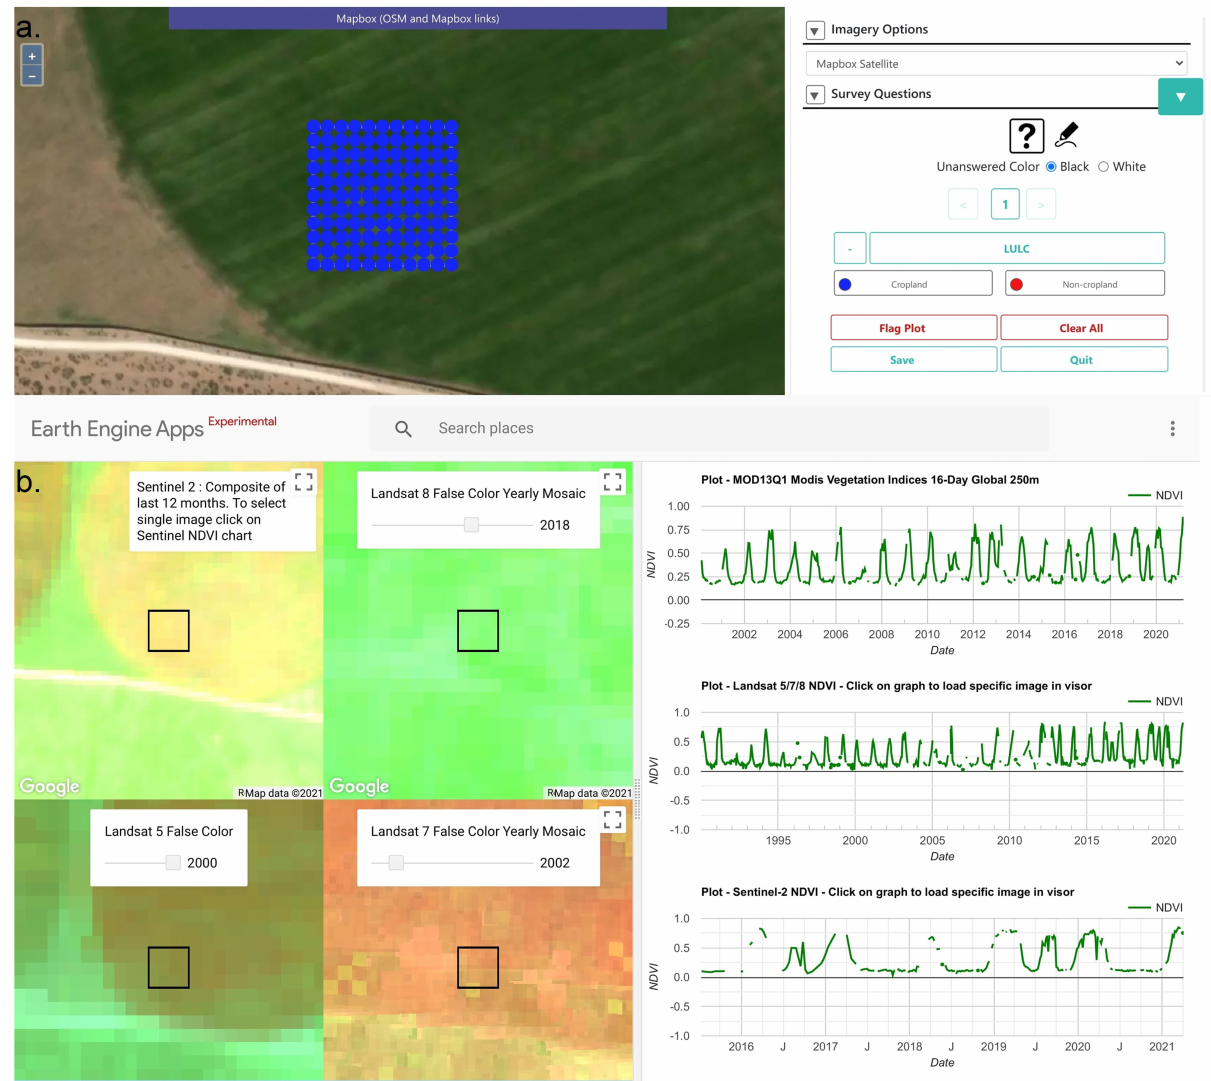
Figure 4. Tools used to collect the reference observations. ( a ) Collect Earth interface and survey; ( b ) time series tools online viewer within